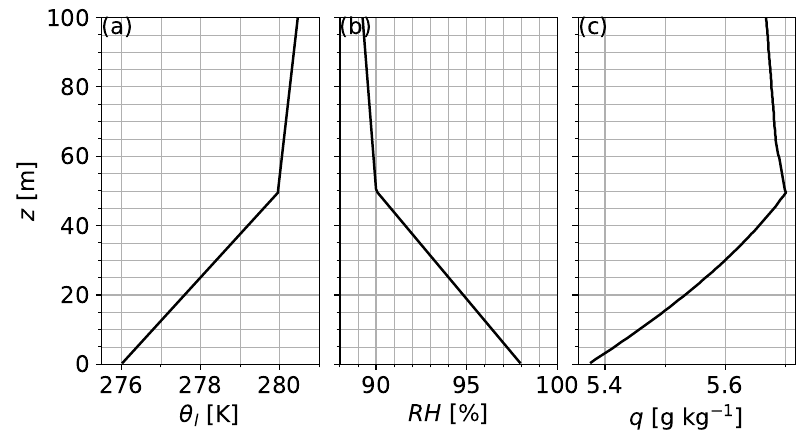
Figure A2. Initial profiles, as described in [5] of ( a ) temperature, ( b ) relative humidity, and ( c ) specific humidity (calculated from T and RH ) for the BAS